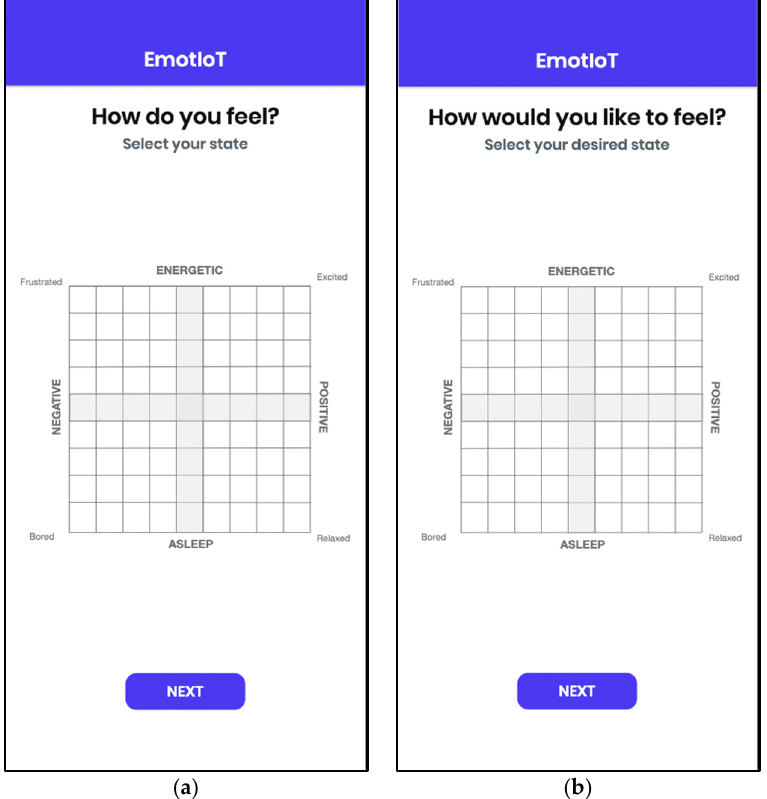
Figure 4. Initial screens for obtaining the initial emotion ( a ) and the desired emotion ( b ).